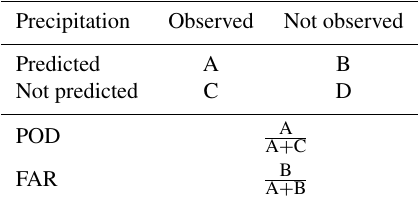
Table 3. Temperature RMSEs in the leave-one-out cross validation for each interpolation